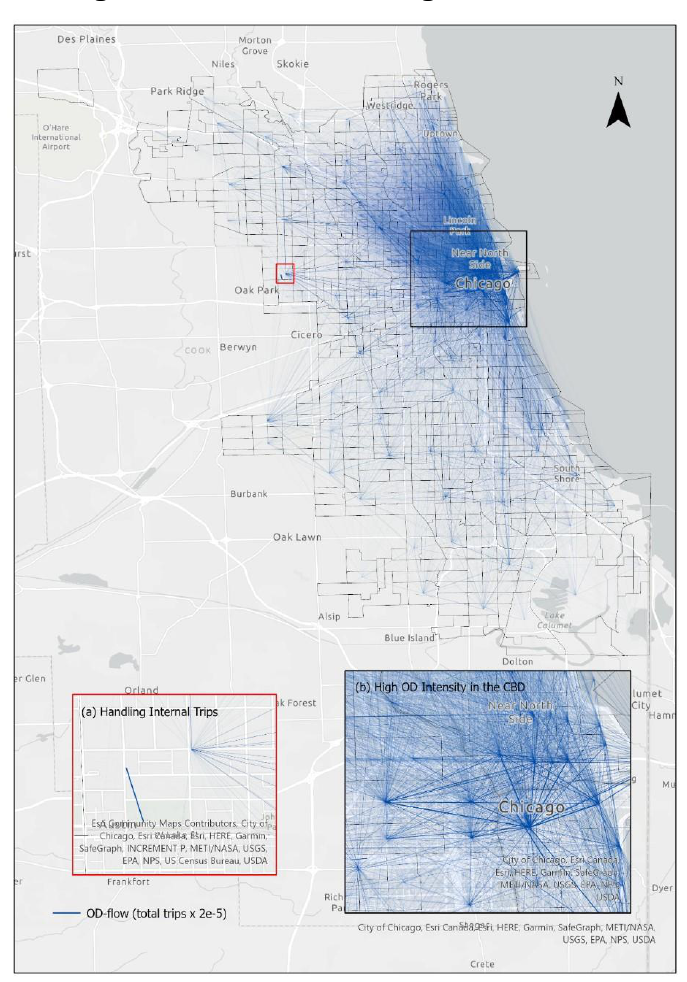
Figure 5: 2019 Ride-sourcing